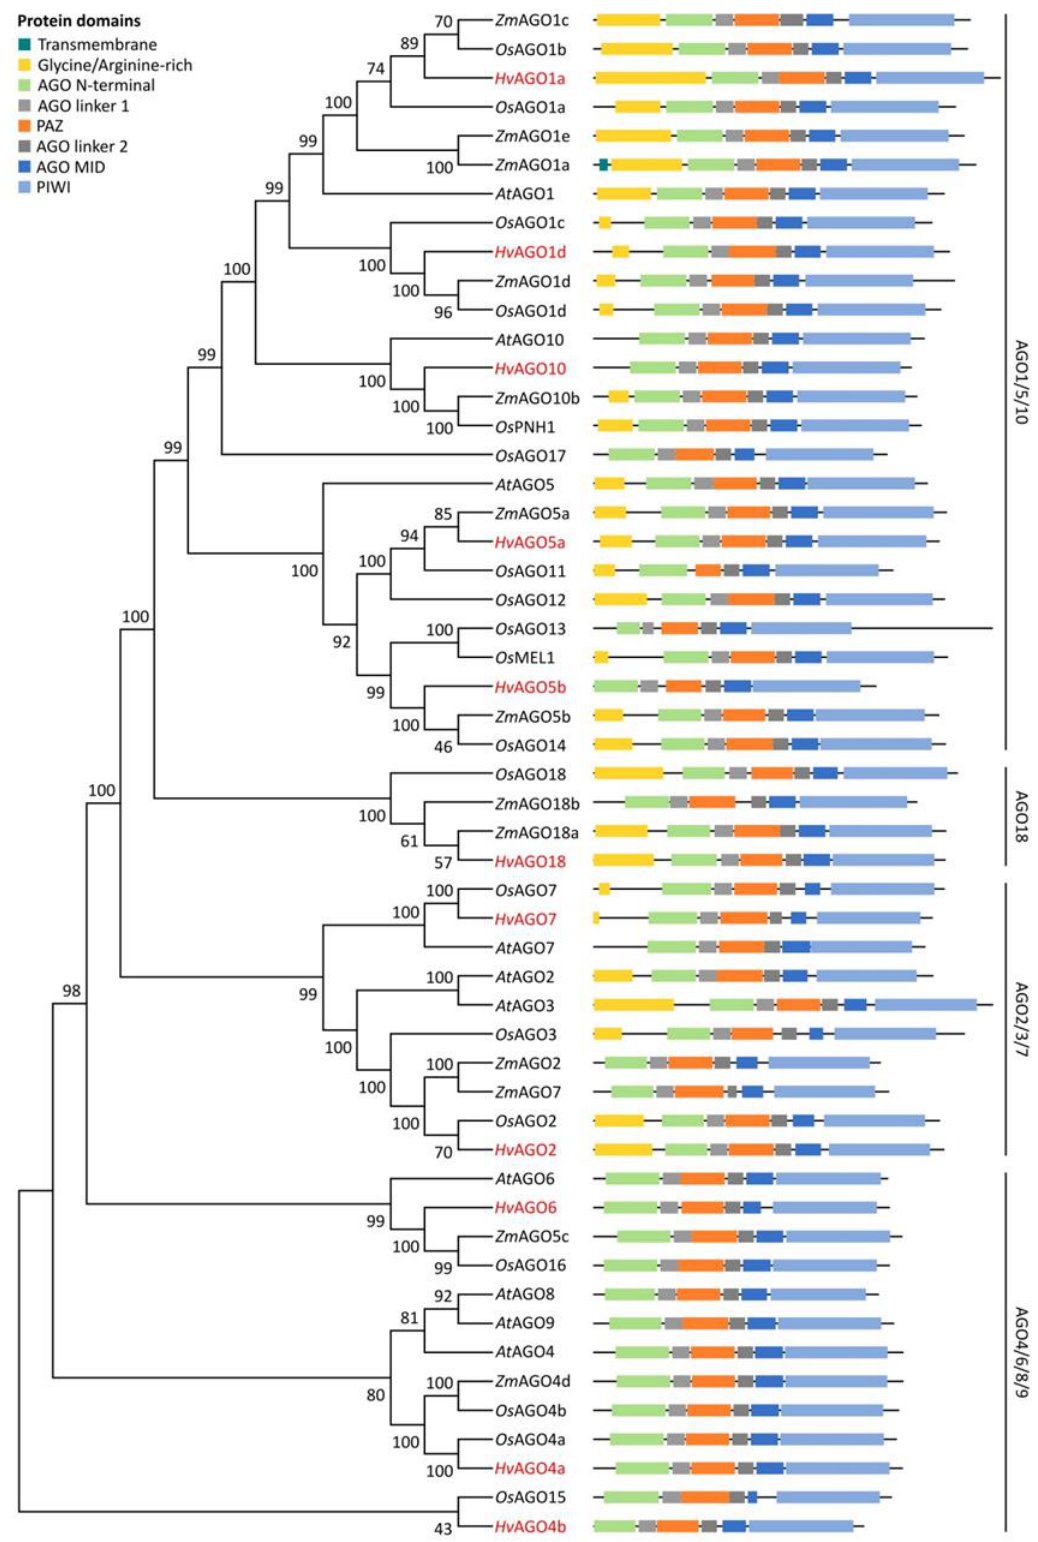
Figure 3. Phylogenetic relationship and conserved domains of A. thaliana , O. sativa , Z mays and H. vulgare AGO proteins. Phylogenetic trees were constructed as described in Figure 1 legend. The bootstrap values are shown next to the branches. Conserved domains were identified with the SMART server [84]. The barley AGOs identified in this study are marked with